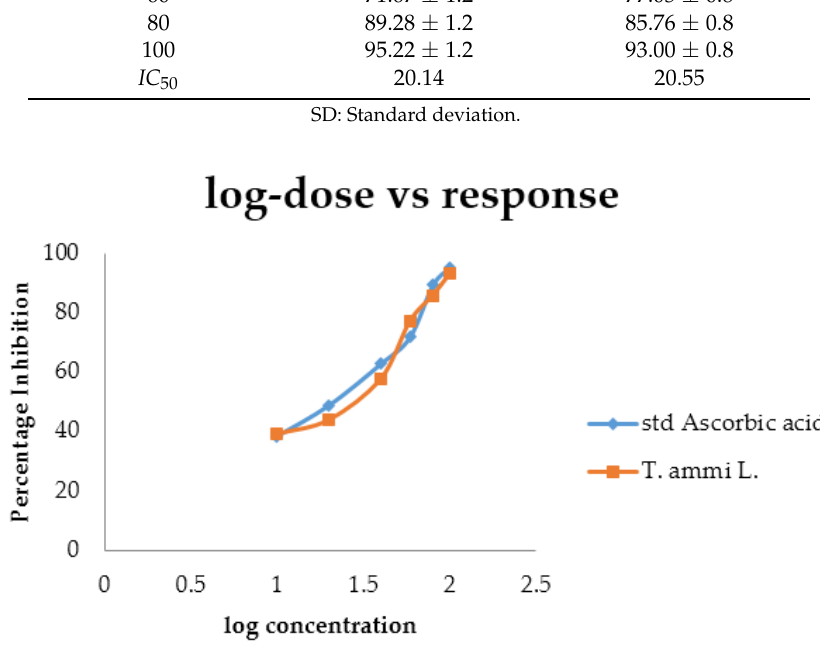
scavenging method ( n = 3).